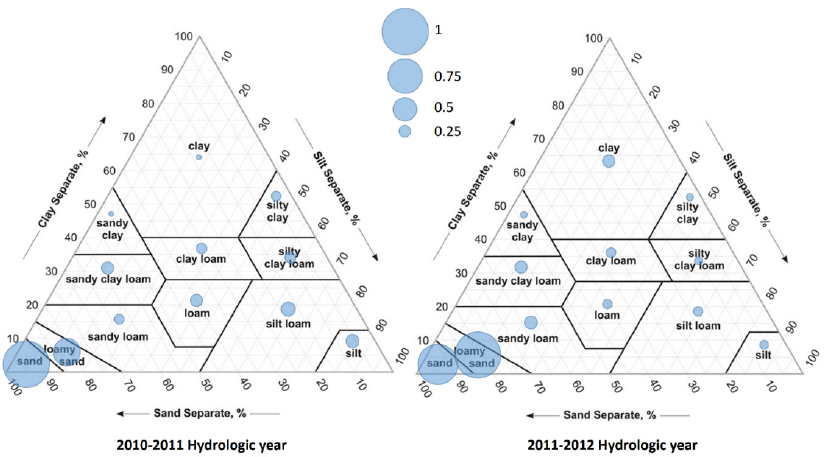
Figure 7. Frost depth, 2010–2011 and 2011–2012 hydrologic years. Results were normalized ranging from 0 to 1; each circle represents the scaled result. A bigger circle indicates the highest value in the metric.